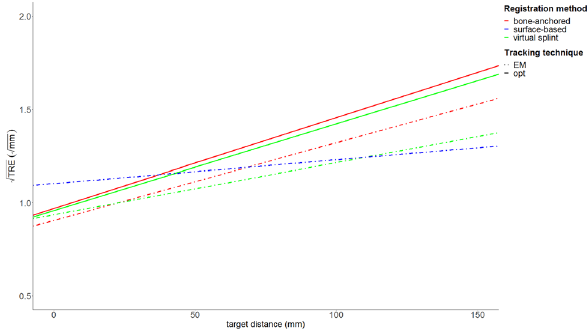
Figure 5. Plot of target distance against √ TRE for each combination of tracking technique and registration method. The plot corresponds to the slope and intercept values presented in Table